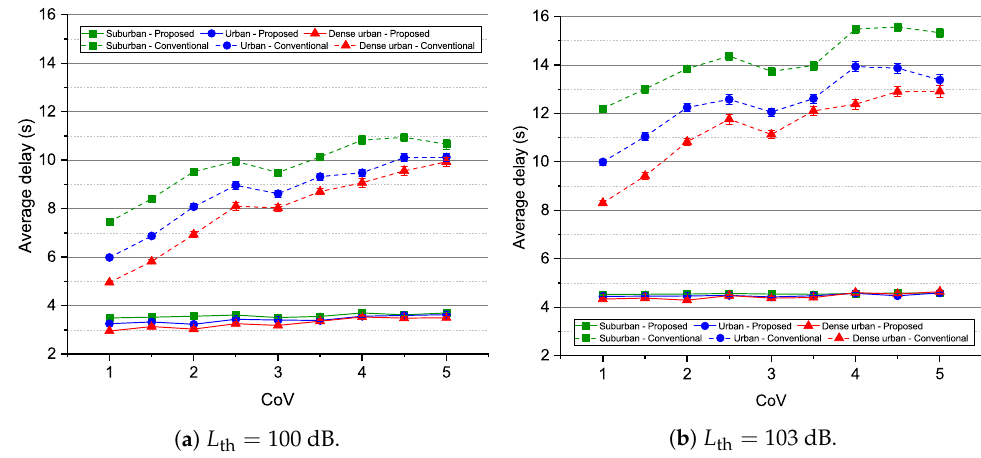
Figure 8. Average delay versus the CoV for different urban environments and threshold path